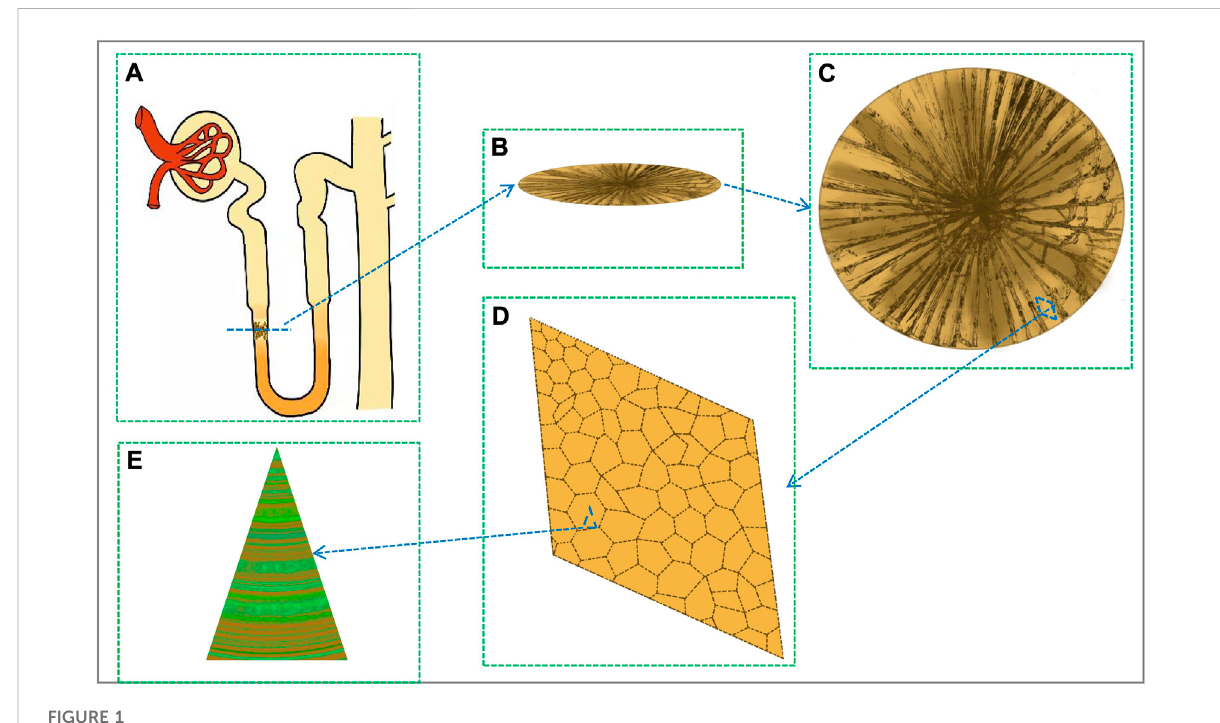
FIGURE 1 The location and crystal structure of stone crystals in the renal tubule. (A) Crystal deposition on the descending limb of Henle ’ s ring. (B) Horizontal section of the crystal. (C) Crystal front side. (D) Crystal enlarged structure. (E) OPN-crystal-bound complex ( fl uorescent green is OPN protein, yellow is